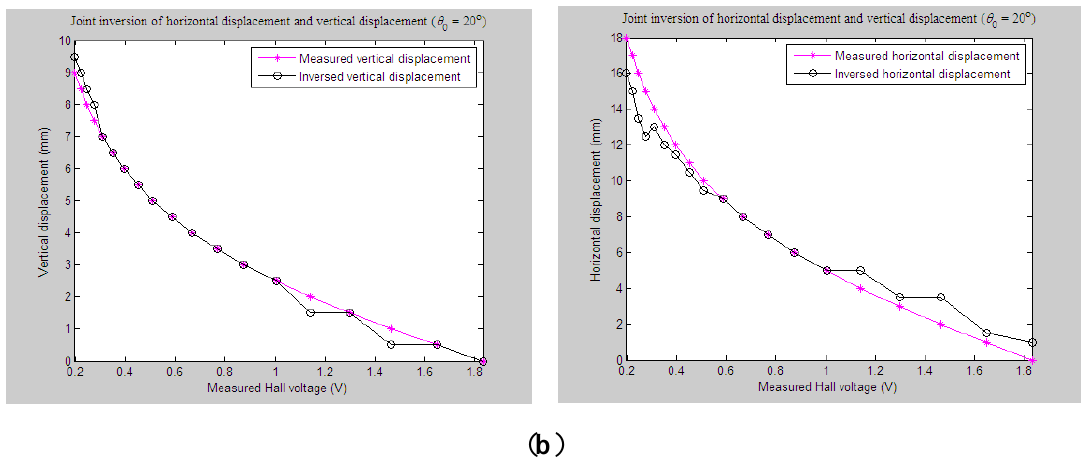
Figure 17. Horizontal and vertical displacement joint inversion results when both measured Δ Z and Δ X are changed ( θ 0 = 20°). ( a ) Measured mutual inductance voltage and Hall voltage; ( b ) inversed horizontal and vertical